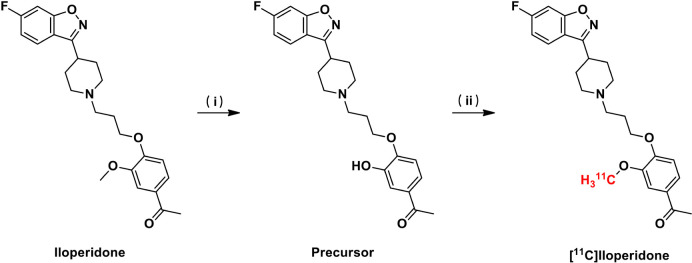
Radiosynthesis of [11C]iloperidone. Reagents and conditions: (i) H2SO4, 65°C, yield 85%. (ii) [11C]CH3I, K2CO3, DMF, 80°C, yield 12% (decay corrected).